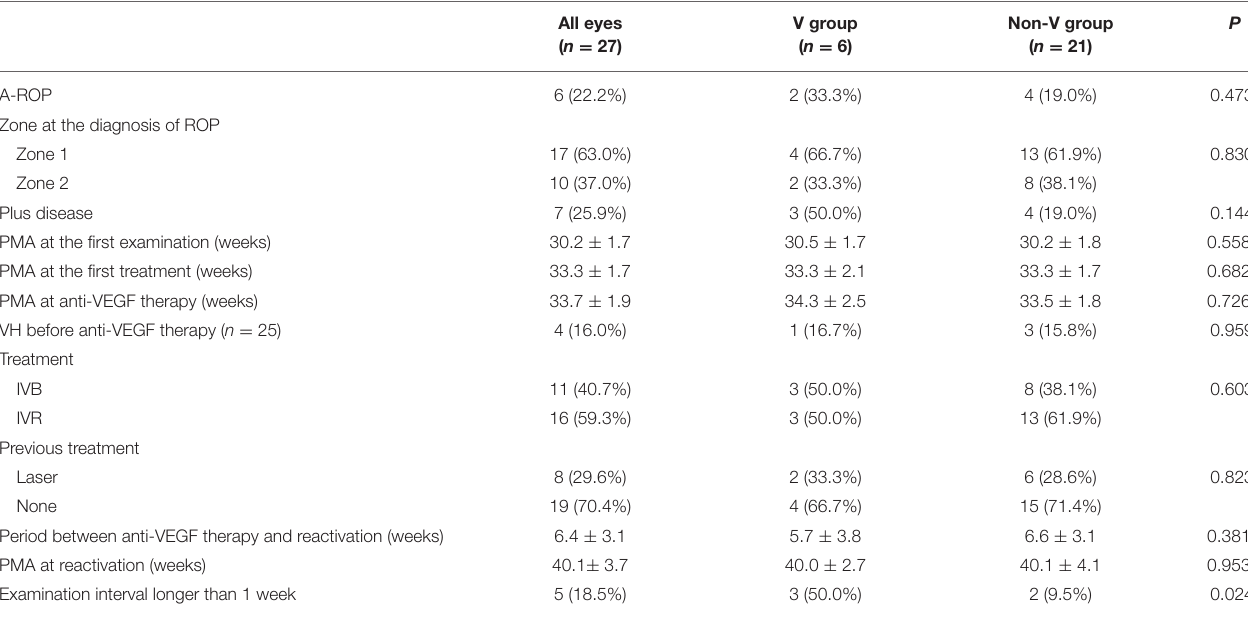
TABLE 3 | Ocular characteristics of eyes showing